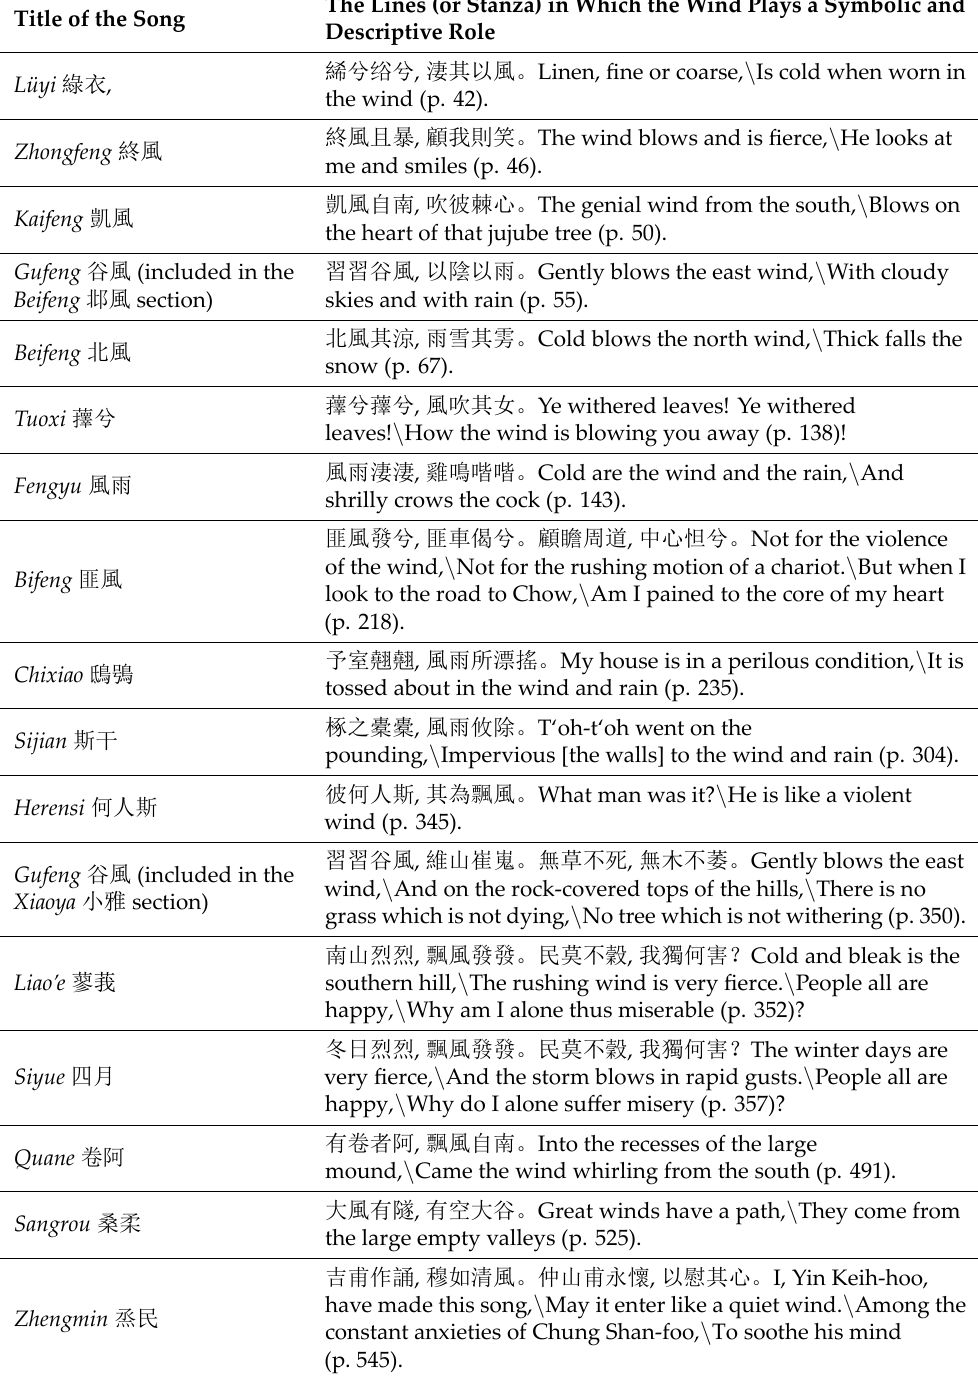
Table 1. Summary of the symbolic and descriptive role of the wind discussed in Section 3. (English translation is cited from James Legge, The Chinese Classic: The She King; or, the Book of Poetry . Hong Kong: Hong Kong University Press,